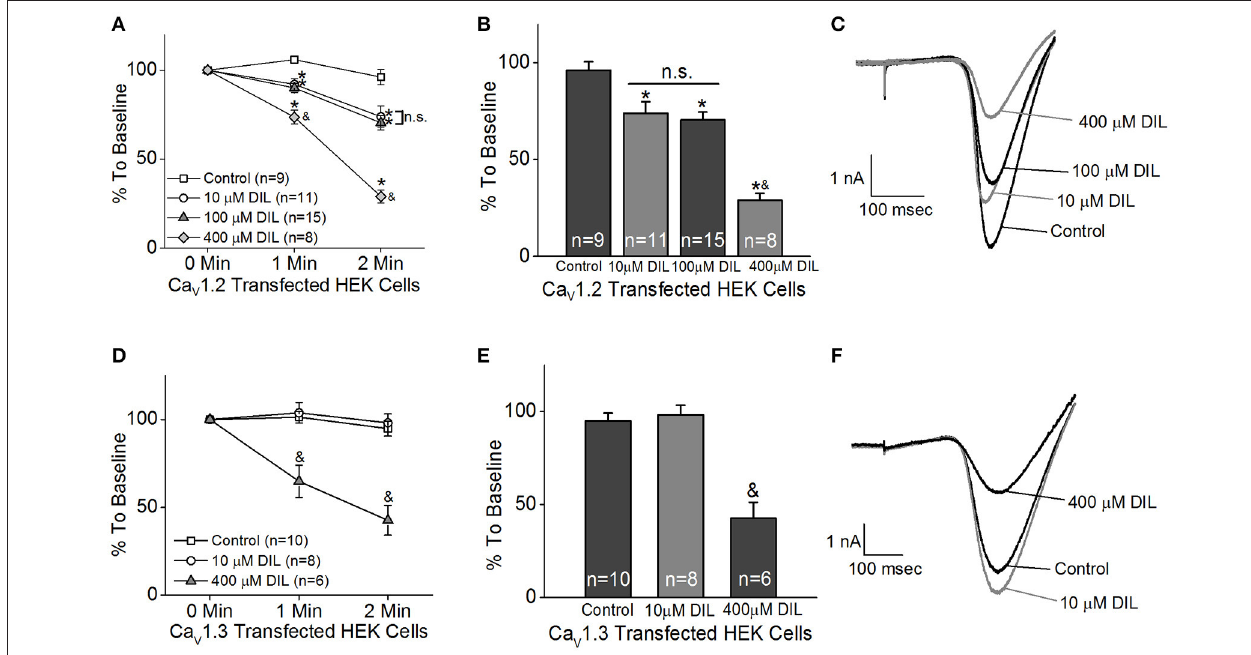
FIGURE 1 | Different concentrations of diltiazem (DIL) are able to differentiate Ca v 1.2-LTCC from Ca v 1.3-LTCC currents in cultured HEK cells. The LTCC currents were recorded from Ca v 1.2-transfected HEK cells (A–C) and Ca v 1.3-transfected HEK cells (D–F) under the whole-cell patch-clamp configuration. (A) Perfusion with DIL at 10, 100, or 400 µ M significantly decreases Ca v 1.2-LTCC currents recorded from HEK cells transfected with Ca v 1.2. (B) Perfusion with 10, 100, or 400 µ M DIL for 2min causes a reduction of Ca v 1.2-LTCC currents. (A,B) The asterisk (*) indicates a statistically significant difference between the control and the 10, 100, and 400 µ M DIL groups; “ & ” indicates that the 400 µ M DIL group is statistically different from the other 3 groups; “n.s.” indicates that there is no statistical difference between the 10 and 100 µ M DIL groups. (C) Representative traces recorded from the Ca v 1.2-transfected HEK cells perfused with 0 (control), 10, 100, or 400 µ M DIL are shown. (D) Diltiazem (DIL) at 400 µ M, but not at 10 µ M, causes a decrease in Ca v 1.3-LTCC currents recorded from HEK cells transfected with Ca v 1.3. (E) Perfusion with 400 µ M DIL for 2min causes a reduction of Ca v 1.3-LTCC currents by more than 50%. (D,E) “ & ” indicates that the 400 µ M DIL group is statistically significant from the control and the 10 µ M DIL group. (F) Representative traces recorded from the Ca v 1.3-transfected HEK cells perfused with 0 (control), 10, or 400 µ M DIL are shown. * , & p < 0.05.